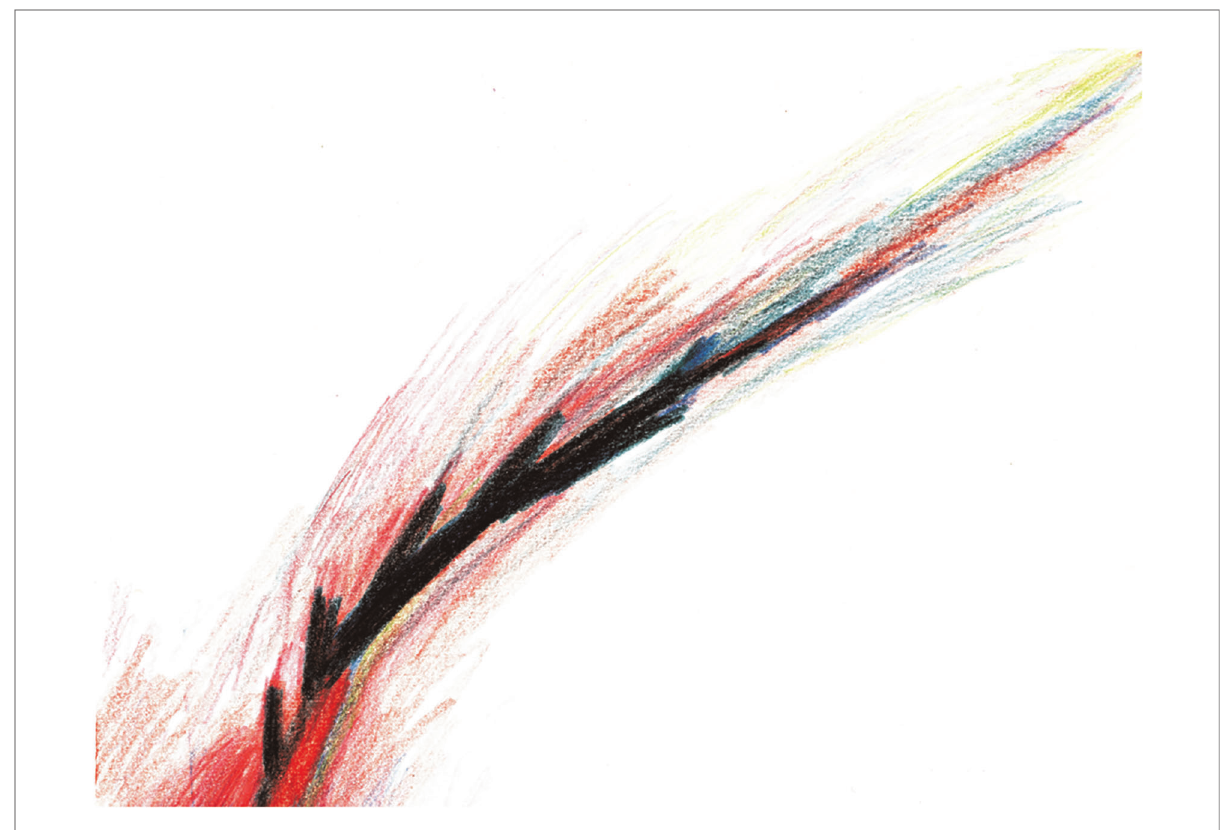
FIGURE 3 Pain as a multi-colored dark